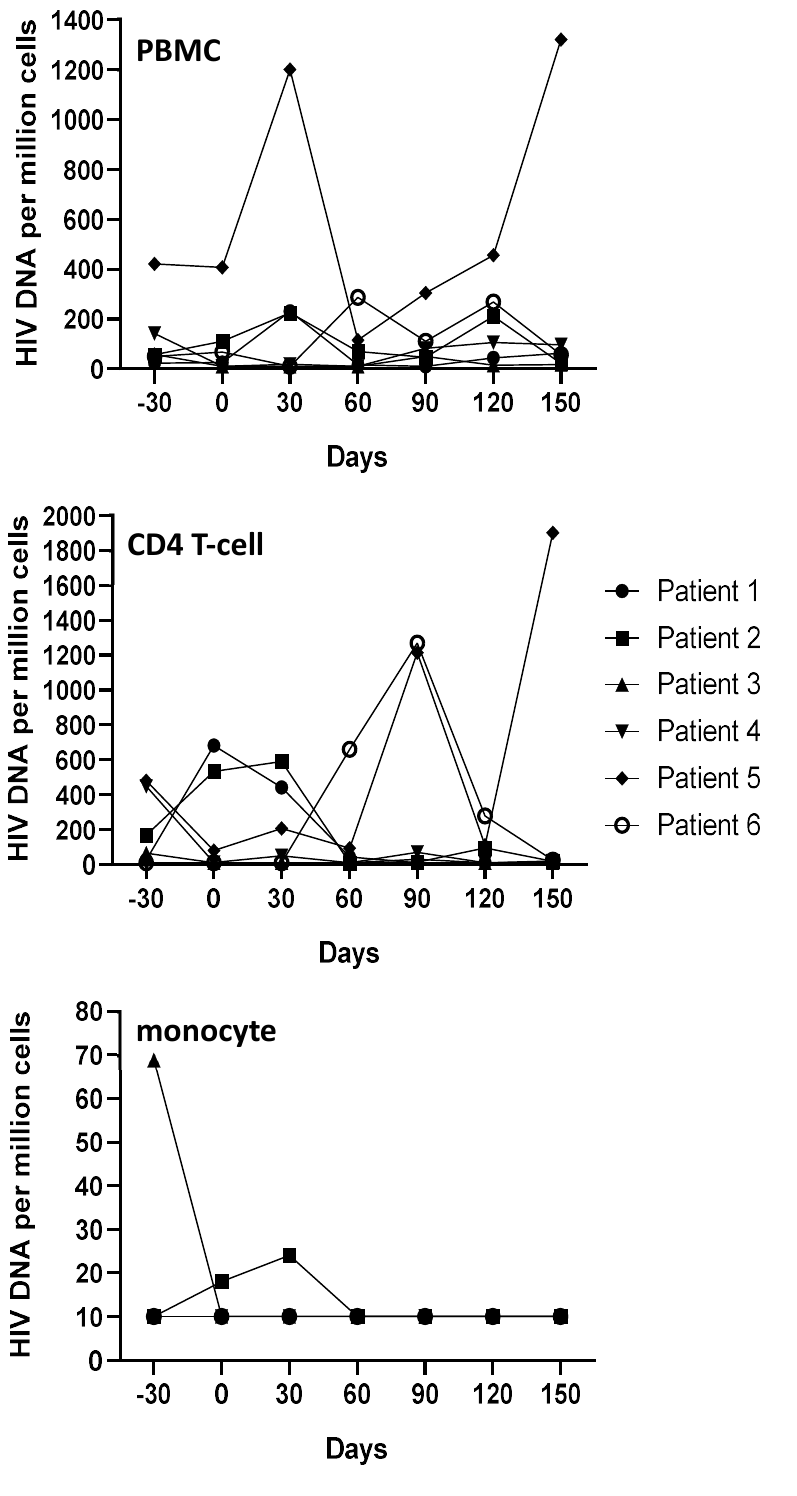
Figure 1. Kinetics of intracellular viral DNA over 7 months of the study protocol. Raltegravir was associated with the current antiretroviral combination from Day 0 to Day 90 ( X -axis) with quantification of intracellular HIV DNA per million cells ( Y -axis), in peripheral blood mononuclear cells (PBMC), purified CD4 T-cells, and monocytes. A higher quantity of HIV DNA was detected in CD4 T-cells, while monocyte concentrations appeared low to undetectable. Variations of intracellular HIV DNA in PBMC were unpredictable, but it was decreasing in CD4 T-cell subsets, except in patients 5 and 6, as well as in monocytes in which no HIV DNA was detected over Day